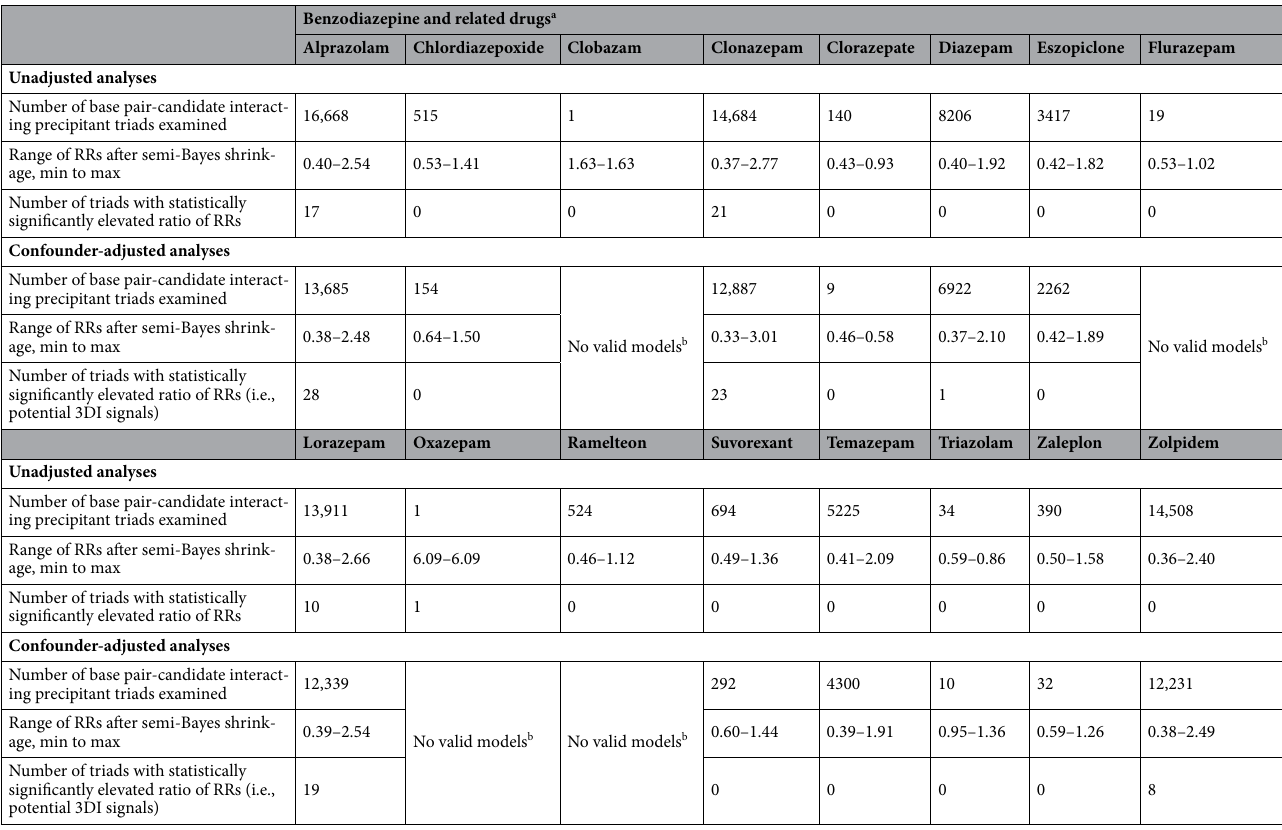
Table 2. Summary data on rate ratios for unintentional traumatic injury, by benzodiazepine and related drug. max, maximum; min, minimum; RR, rate ratio. a Estazolam, quazepam, and tasimelteon were also examined but no models were run because none of the base pair-candidate interacting precipitant combinations had ≥ 5 exposed patients. b Models were run, but none had valid results (i.e., either model did not converge or variance estimate >